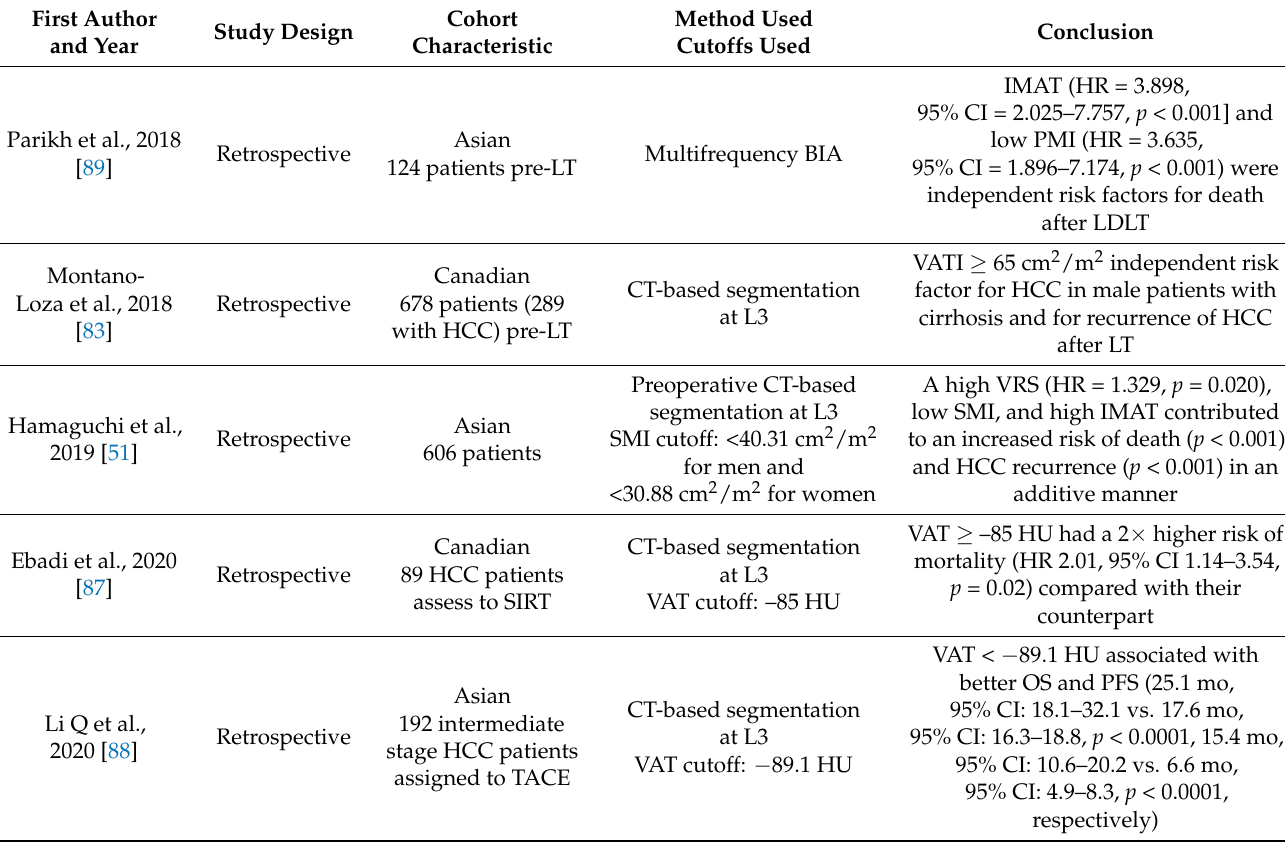
Table 4. Studies assessing the correlation between visceral adipose tissue and the outcome of HCC patients published in the last 5